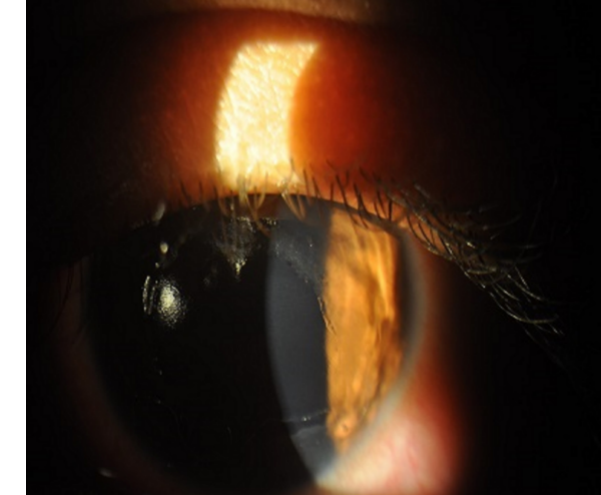
Figure 3: Slit lamp photo of both eyes after treatment